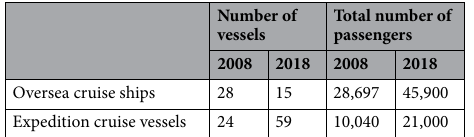
Table 2. Increase in the number of cruise passengers visiting the archipelago of Svalbard 17